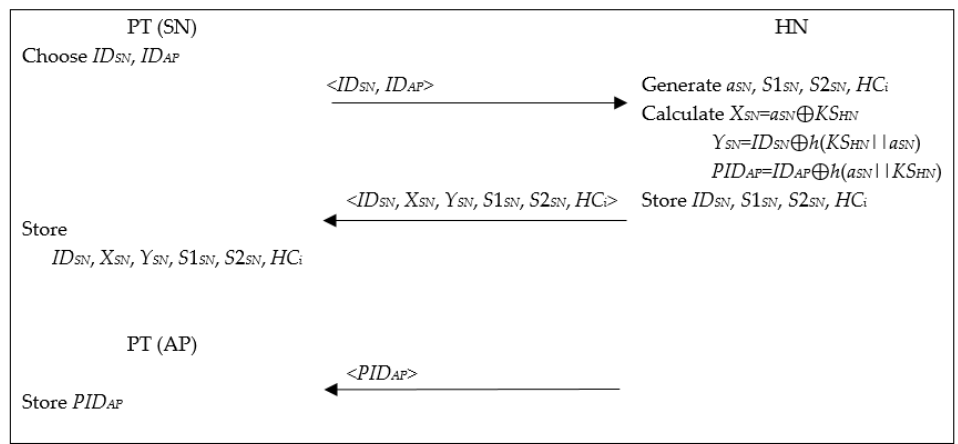
Figure 2. Registration phase.